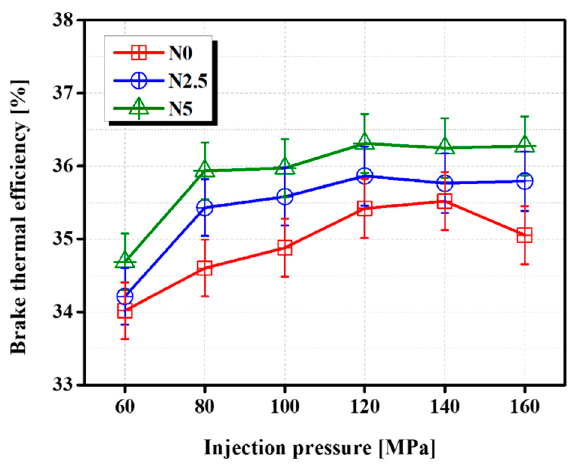
Figure 8. Curve analysis of brake thermal efficiency according to injection pressure for n -octanol/diesel blends.